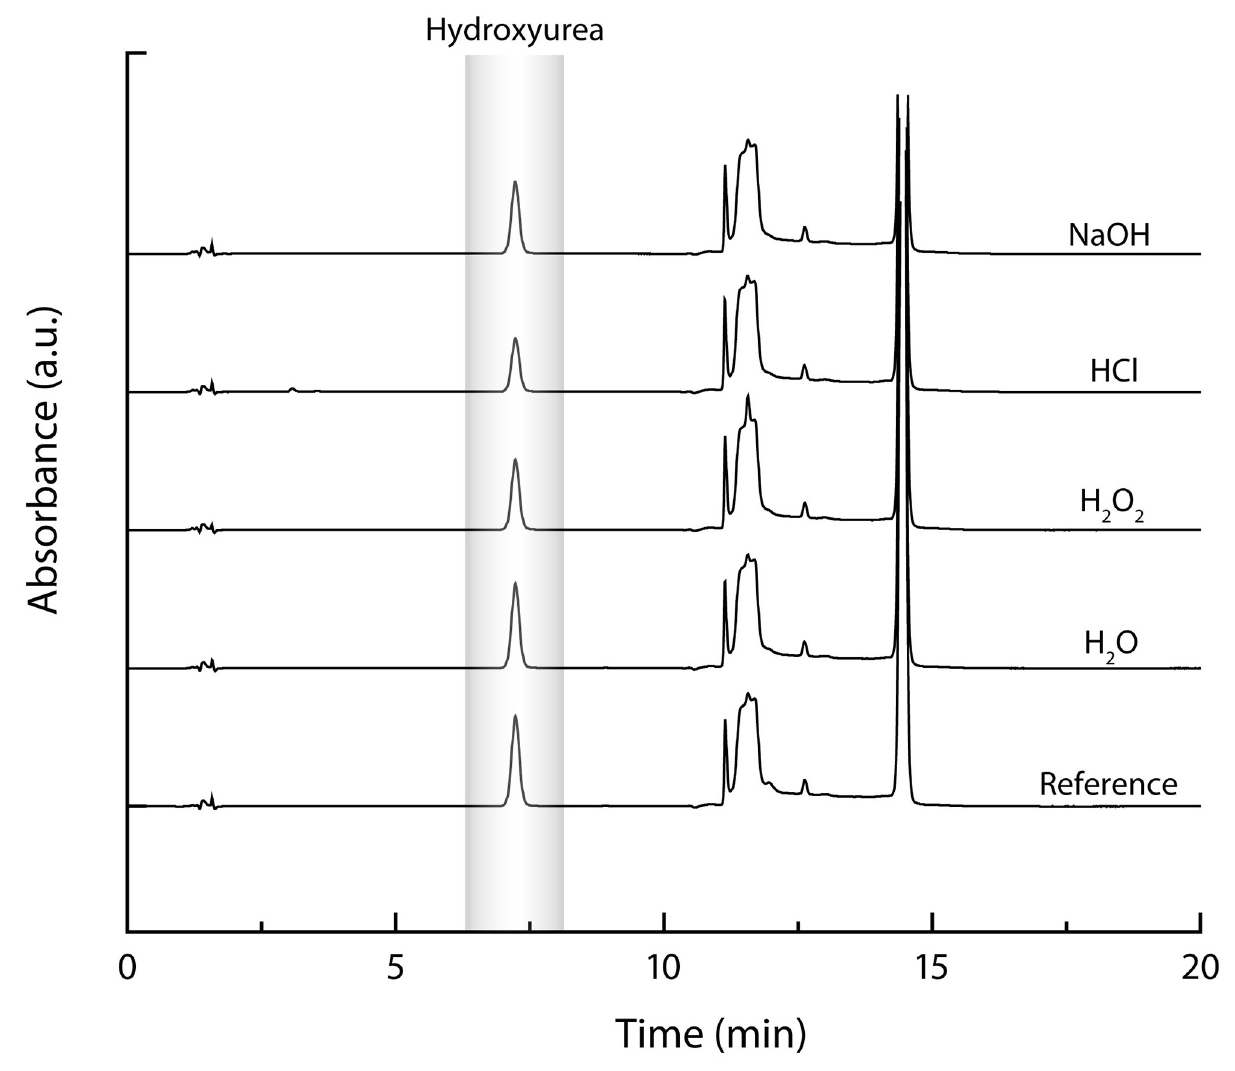
Fig 1. Representative chromatograms of forced degradation of